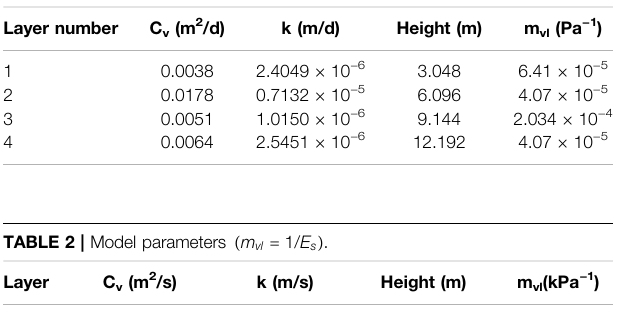
TABLE 1 | Parameters of Lee ’ s model ( m vl (cid:1) 1/ E s ) .